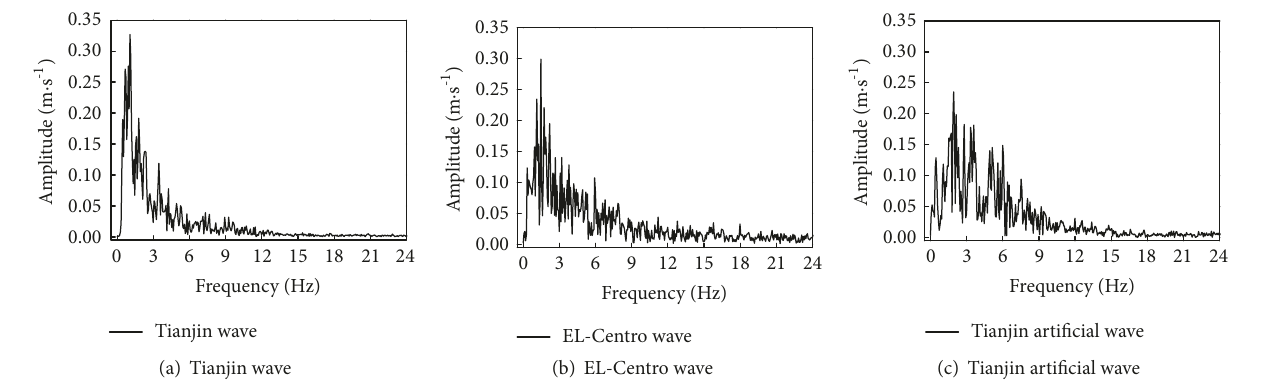
Figure 22: Seismic wave frequency